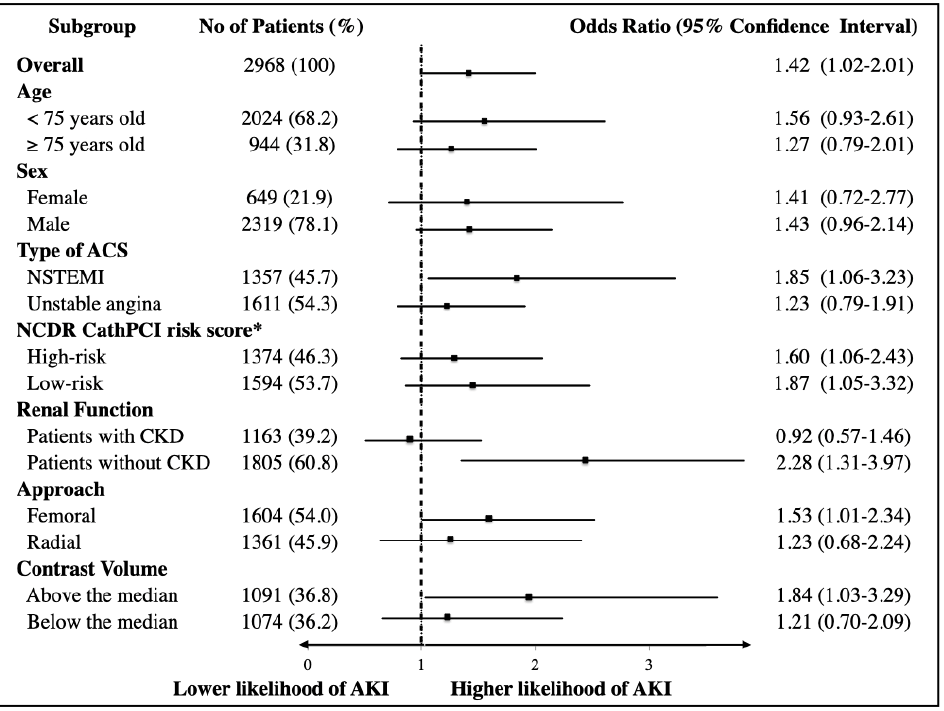
Figure 4. The association between EIS utilization and acute kidney injury. Subgroup results for adjusted ORs (point estimate) and 95% CIs (error bars), which indicate the likelihood of acute kidney injury with an early invasive strategy utilization. ORs > 1 indicate increased odds of acute kidney injury with an early invasive strategy utilization. All analyses were adjusted for sex, age ( ≥ 75 years), prior heart failure, diabetes mellitus, PAD, chronic kidney disease (eGFR < 60 mL / min / 1.73 m 2 ), decompensated heart failure at arrival (NYHA class III or IV), increased cardiac troponin levels, prior revascularization (PCI and / or coronary artery bypass graft) and cardiogenic shock or cardiopulmonary arrest during the course. *Below and above the calculated median NCDR CathPCI risk score. Abbreviations; ACS, acute coronary syndrome; NSTEMI, non-ST elevation myocardial infarction; early invasive strategy;